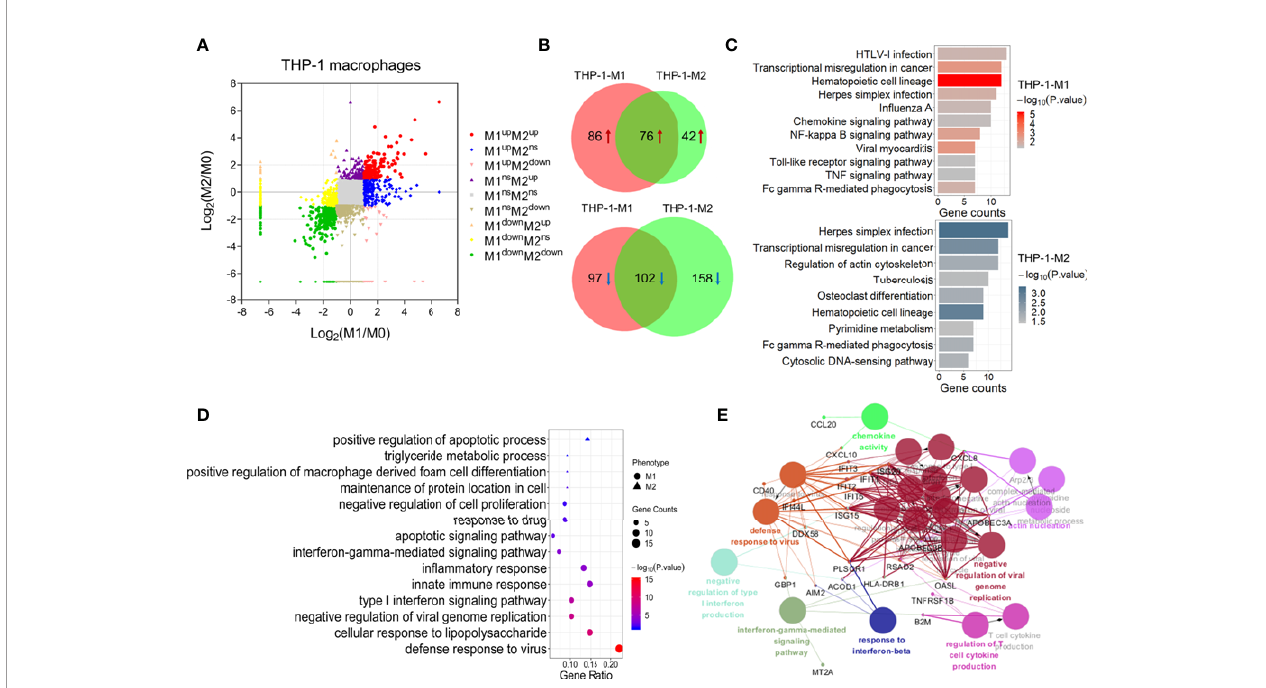
FIGURE 2 | Identi fi cation and bioinformatic analysis of differentially expressed proteins from M1 and M2 types of polarized human THP-1 macrophages. (A) Scatter plot showing the distribution of differentially expressed proteins in M1 and M2 polarized macrophages, compared with the M0 macrophages. (B) Venn diagram of differentially expressed proteins between two types of polarized cells. Upper: up-regulated; lower: down-regulated. (C) KEGG pathway analysis of differentially expressed proteins in M1 (upper) and M2 (lower) macrophages from human THP-1 cells. (D) Gene oncology enrichment analysis (biological process) of up-regulated proteins in M1 or M2 phenotype. (E) The enriched biological processes corresponding to the up-regulated proteins in M1 macrophages ( P -value